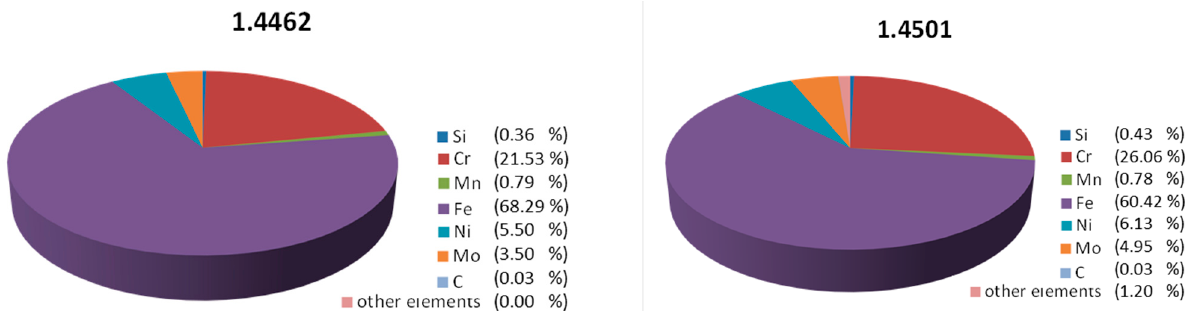
Figure 1. The chemical composition of the tested steels—EDS microanalysis. Both samples are high-alloy steels. The qualitative and quantitative differences can be noticed in their composition. The largest quantitative differences concern the elements Cr, Ni, Mo and Fe.